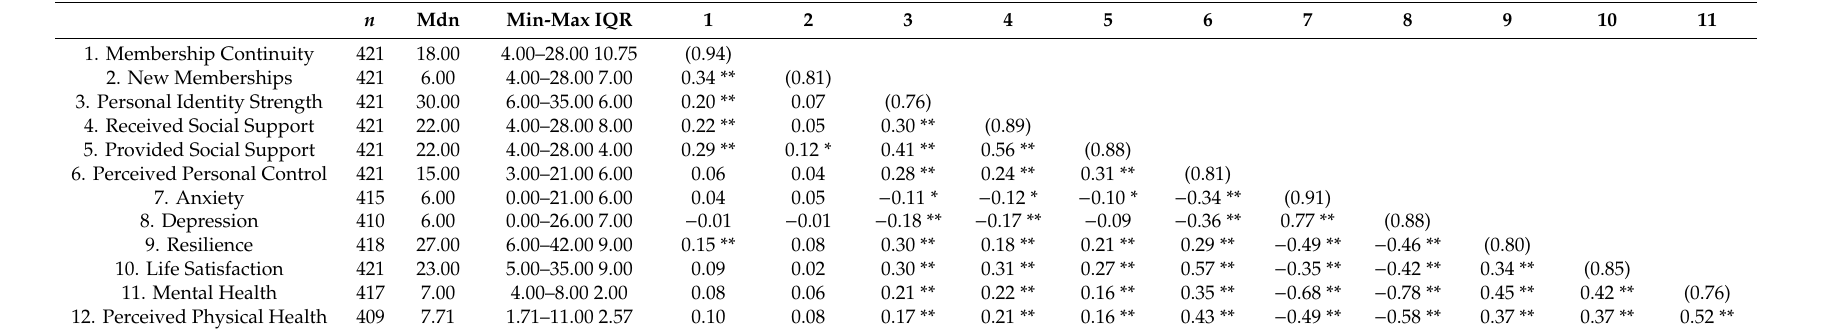
Table 7. Descriptive Statistics and Spearman’s rank correlation coe ffi cient for Quantitative Study